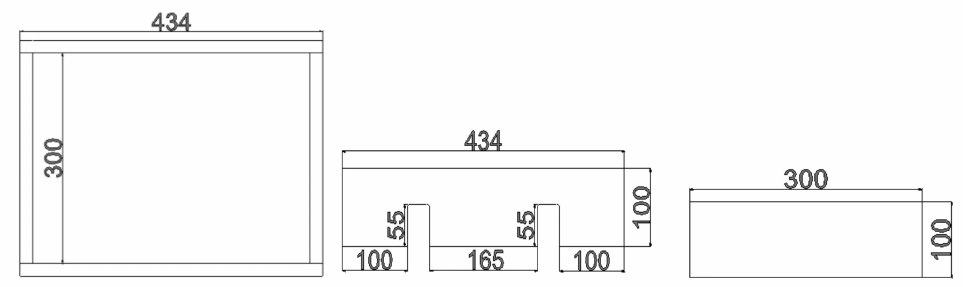
Figure 6. A total of 7–9 bolts were used to fix the profiled sheet to timber plywood.